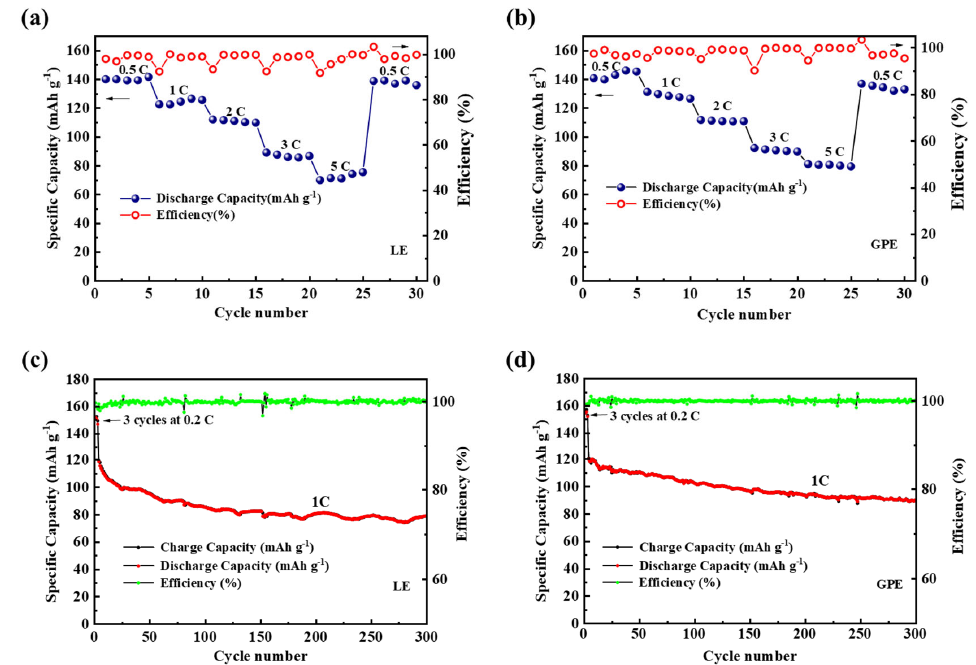
Figure 7. Rate capability of ( a ) Zn/LE/LFP and ( b ) Zn/GPE/LFP, respectively. Cycle performances and Coulombic efficiency of the ( c ) Zn/LE/LFP and ( d ) Zn/GPE/LFP batteries at 1 C.